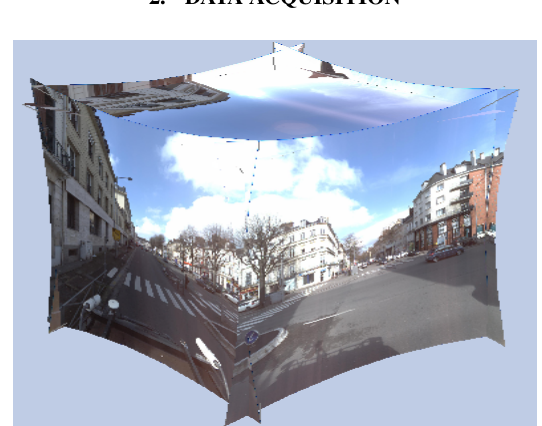
Figure 2. The set of images acquired by the 5 full HD cameras (left, right, up, in front, from